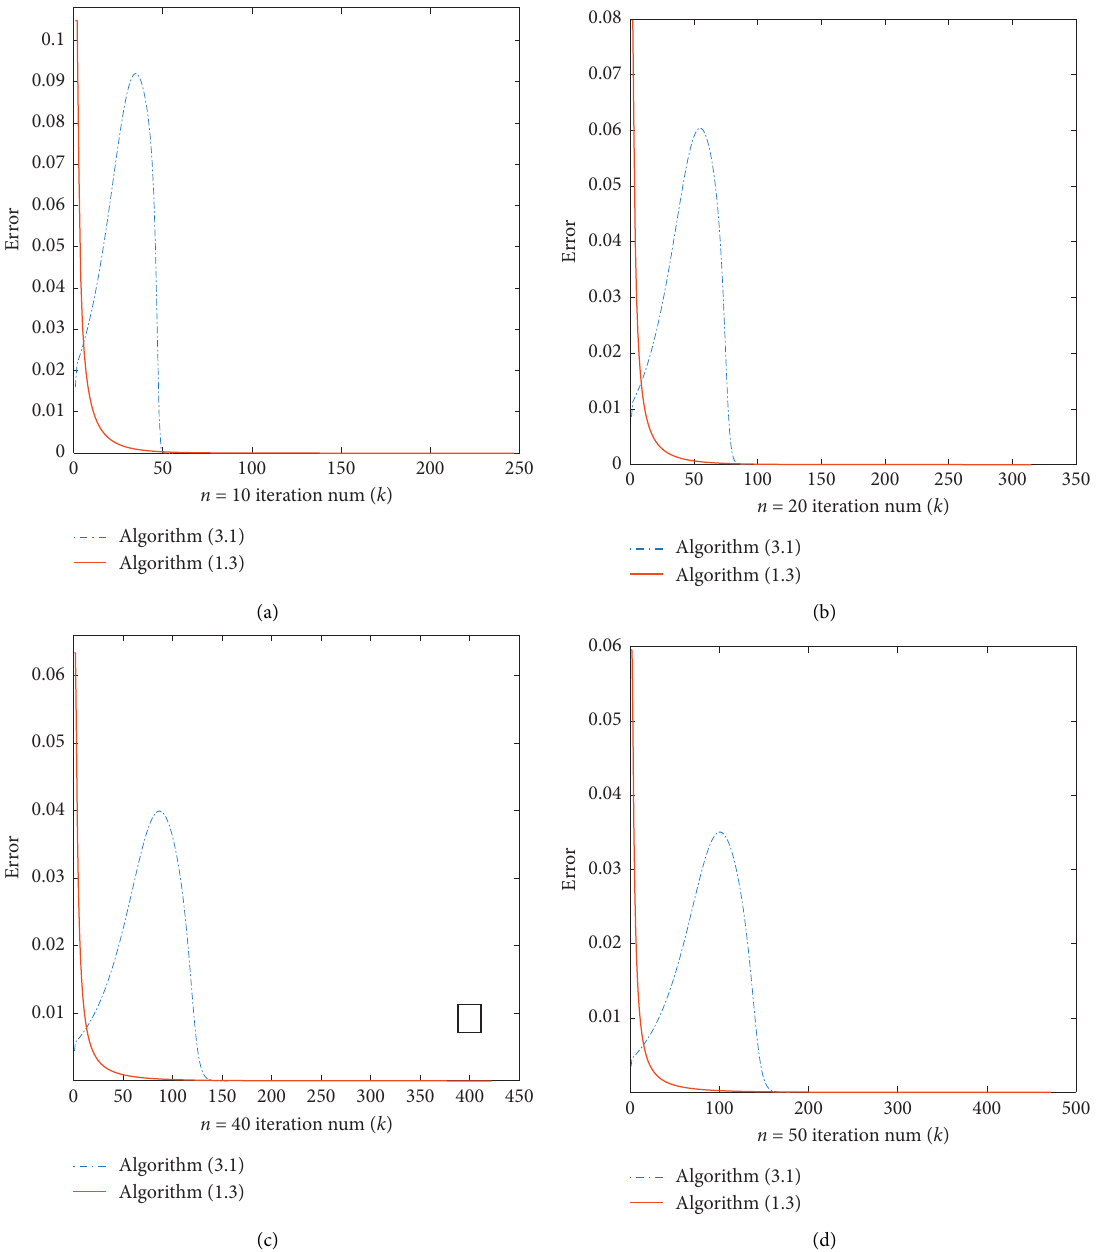
Figure 1: Example cases. (a) Top-Left Case I n � 10; (b) Top-Right Case II � 20; (c) Bottom-Left Case III n � 40; (d) Bottom-Right Case IV n �